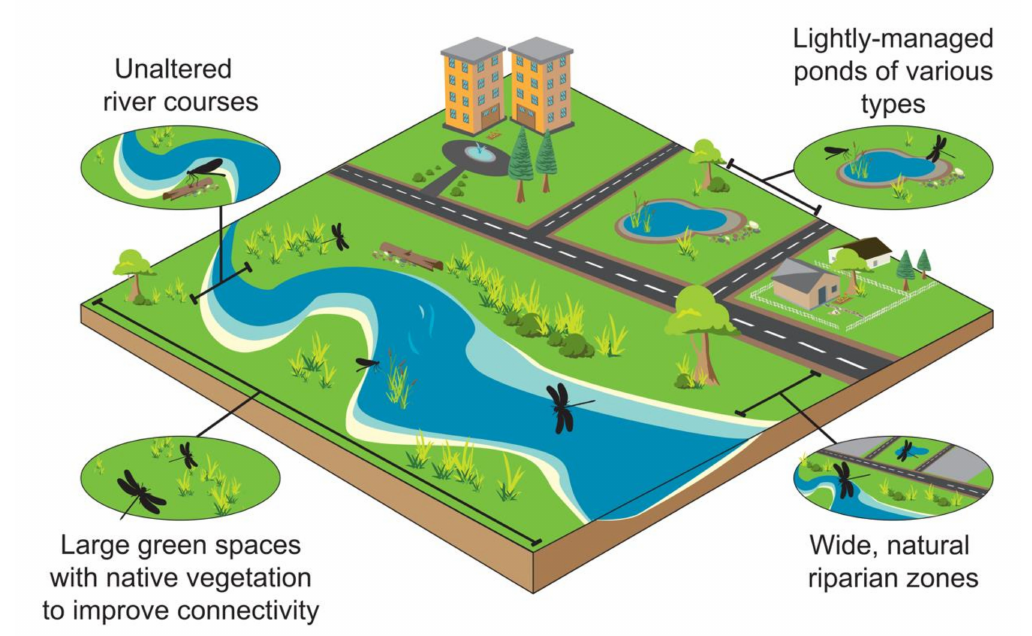
Figure 2. Green and blue spaces provide several opportunities for dragonflies to establish and persist in urban